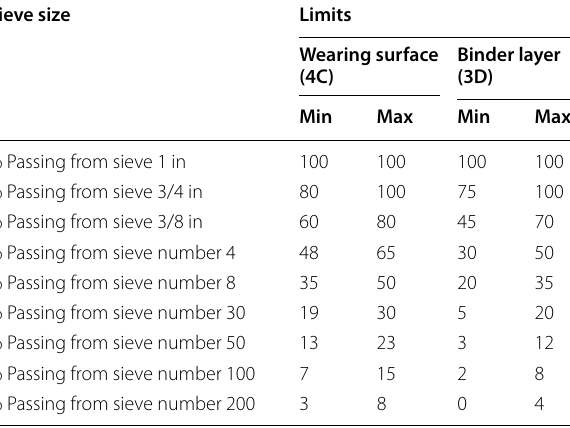
Table 1 Aggregate gradations (4C and 3D) used in the mixes (The Egyptian code for urban and rural roads (ECP, 2008) part